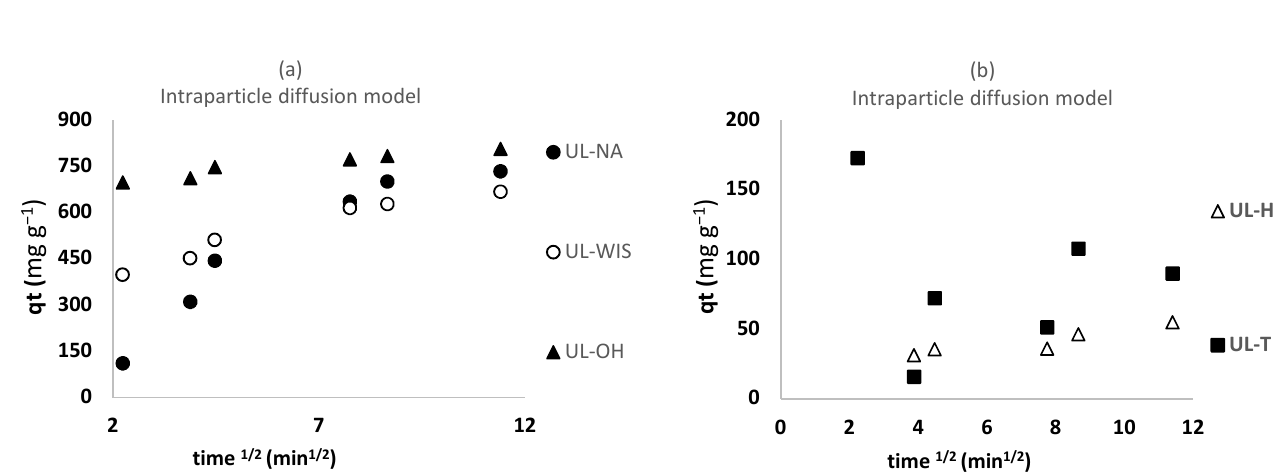
Figure 12. Intraparticle diffusion model of MB adsorbed by dry U. Lactuca biomass: UL-NA, UL-WIS, and UL-OH ( a ), UL-H and UL-T ( b ). Experimental conditions: 5 g L −1 adsorbent concentration, pH = 8, T = 25 °C, C 0 (MB) = 5 × 10 −5 mol L −1 .